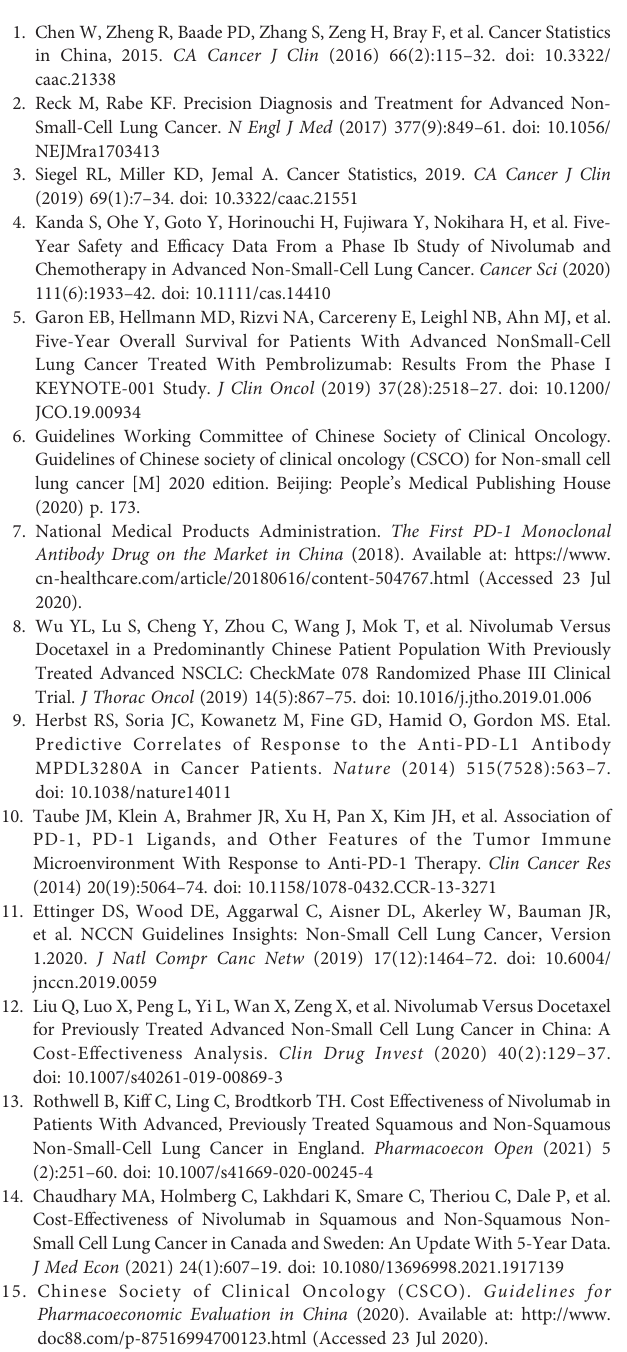
Supplementary Table 1 | Second-linetreatmentregimensanddosageintheModel. Supplementary Table 2 | Parametric survival distributions fi tted for OS data. Supplementary Table 3 | Parametric survival distributions fi tted for PFS data. Supplementary Table 4 | Incidence of treatment-Related grade III/IV Adverse Events considered in the model.